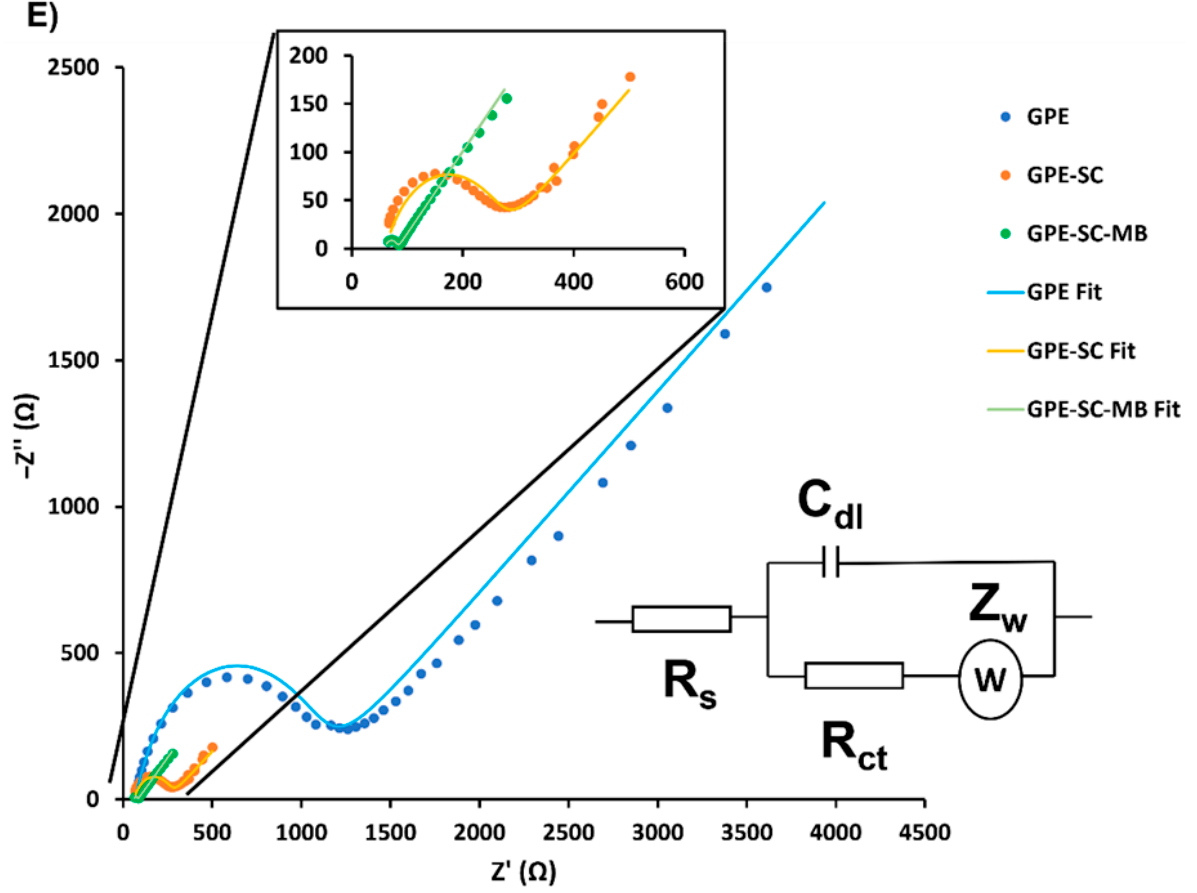
Figure 3. ( A – C ) Voltammograms of the GPE, GPE-SC, and GPE-SC-MB using DPV in the presence (solid line) and absence (dashed line) of the four DNA bases G (33.3 µM), A (33.3 µM), T (333.3 µM) and C (333.3 µM) in 0.2 M phosphate buffer (pH 7.0). ( D ) An overlay of the voltammograms of ( A – C